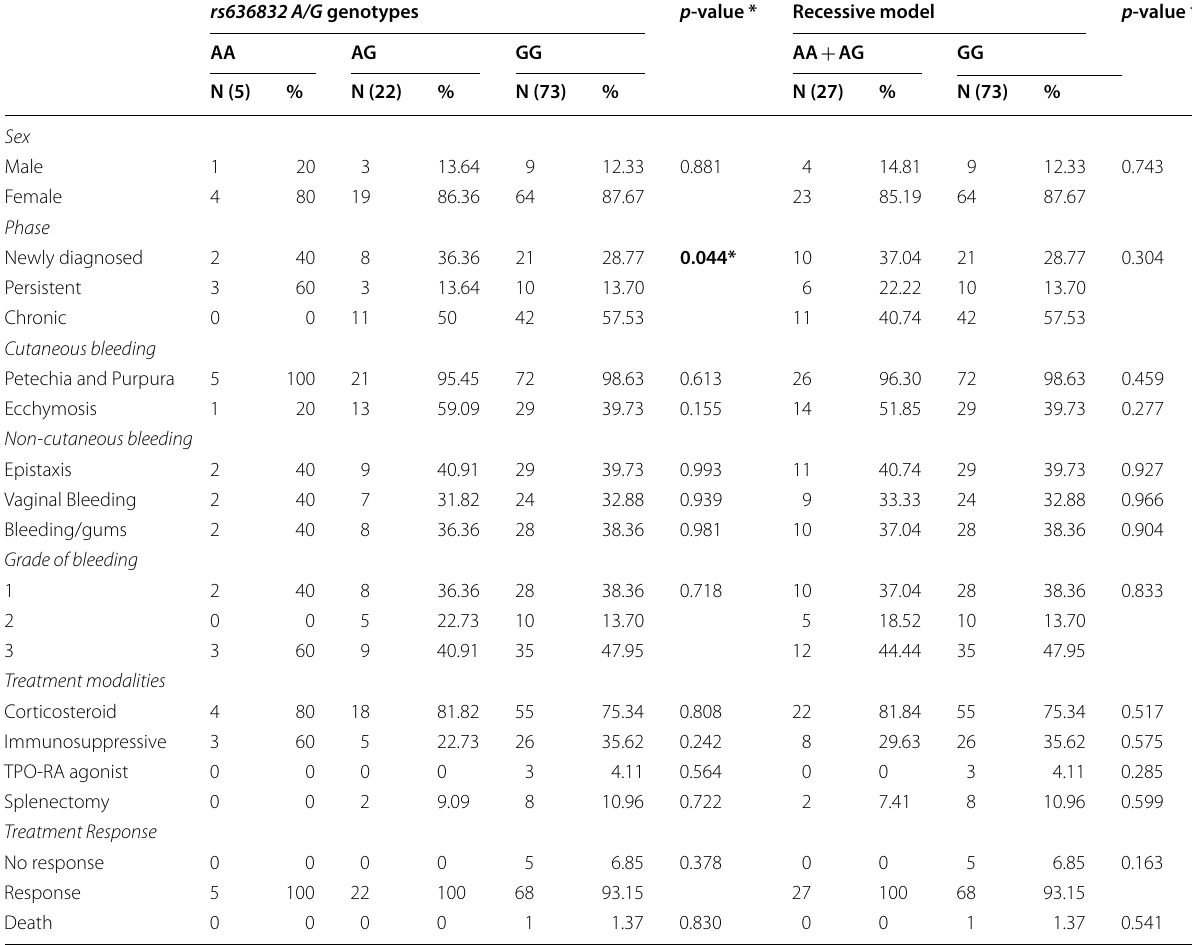
Table 3 rs636832 A/G genotypes frequencies and ITP